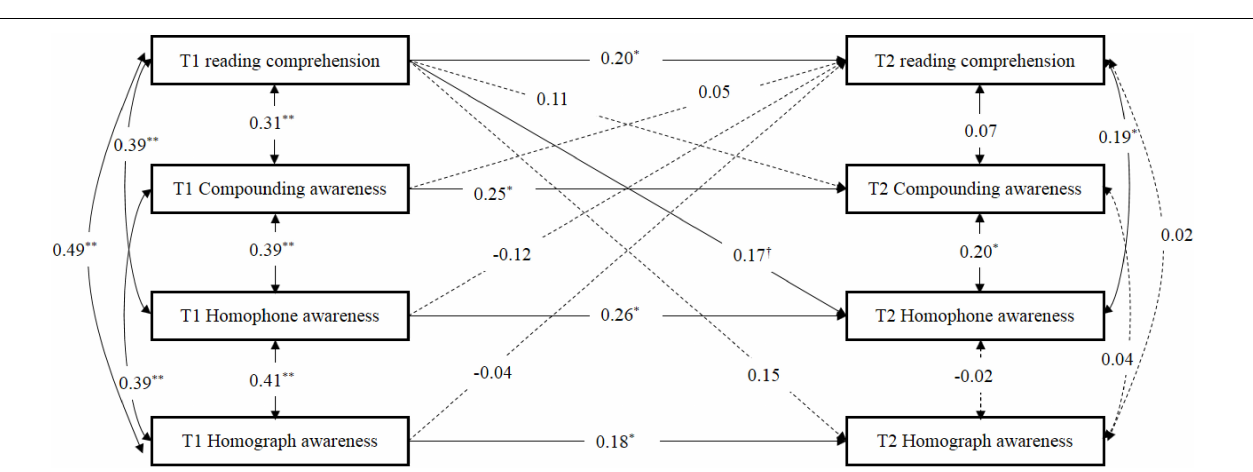
FIGURE 2 | The model to evaluate the longitudinal relationships between compounding awareness, homophone awareness, homograph awareness, and reading comprehension from Grade 3 to 4, after controlling for IQ, rapid number naming, phonological awareness, word reading, and vocabulary knowledge at the initial level. T1, fall of third Grade; T2, fall of fourth Grade. Dashed lines indicate non-significant paths. The control variables are not shown here to simplify the representation of the model. † p < 0.08, ∗ p < 0.05, ∗∗ p < 0.01, two-